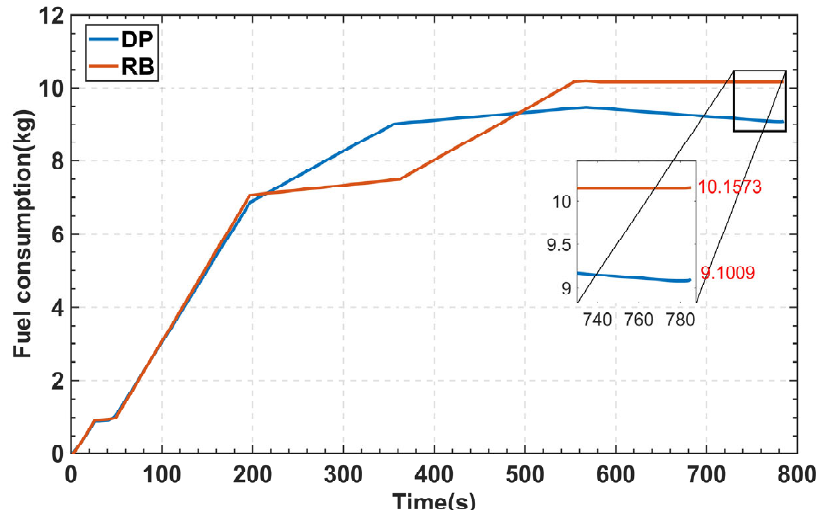
Figure 15. Comparison of fuel consumption between DP and logic threshold rule.